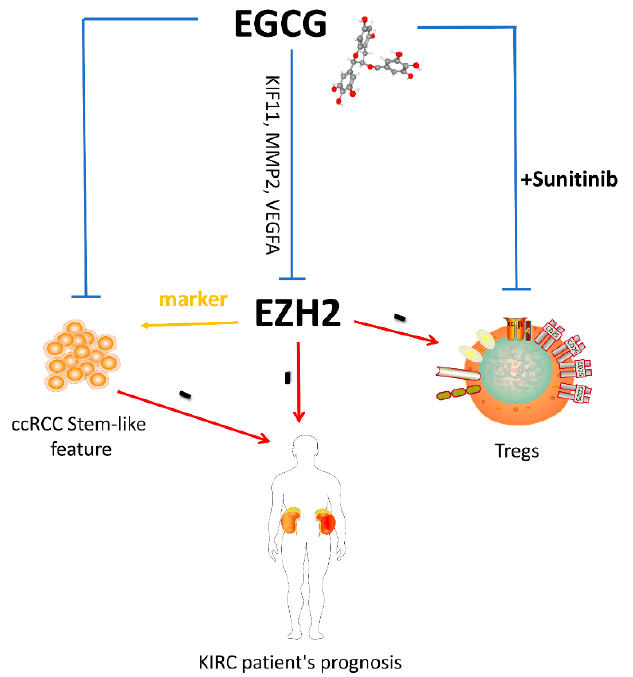
Figure 12. The proposed model for the correlation among EZH2, cancer stem cells, and EGCG for the KIRC